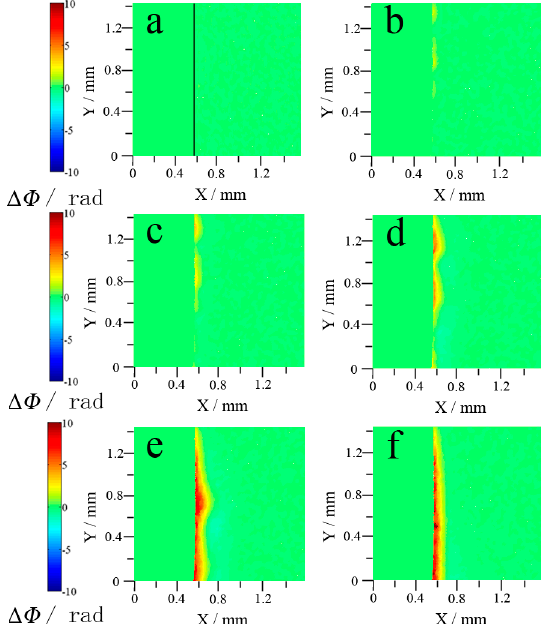
Figure 10. The phase maps at different times in Figure 9 during potentiodynamic polarization of copper in 0.5 M NaCl + 0.01 M NaOH solution. Figure 10( a–f) are corresponding to the points a–f in Figure 9. A dynamic process is available in Video S1.